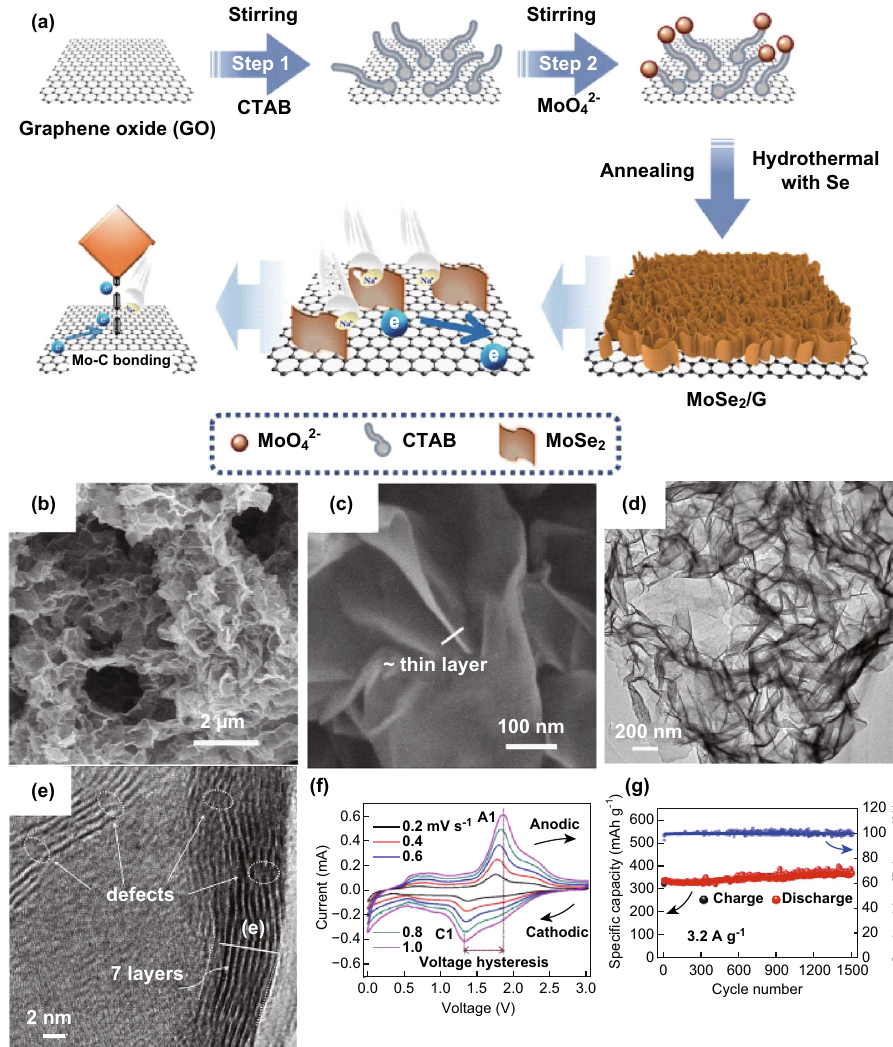
Fig. 15 3D architectures based on 2D MoSe 2 /graphene nanoflakes for SIBs. a Strategy for fabrication of ordered 2D superstructure. b, c SEM images of as-prepared MoSe 2 /G. d TEM and e HRTEM images of as-prepared MoSe 2 /G. f CV curves of MoSe 2 /G superstructure at different scan rates from 0.2 to 1.0 mV s - 1 . g Cycling performance and corresponding Coulombic efficiency of MoSe 2 /G superstructures at a current density of 3.2 A g - 1 for 1500 cycles. Reproduced with permission [129]. Copyright (cid:2) 2018,